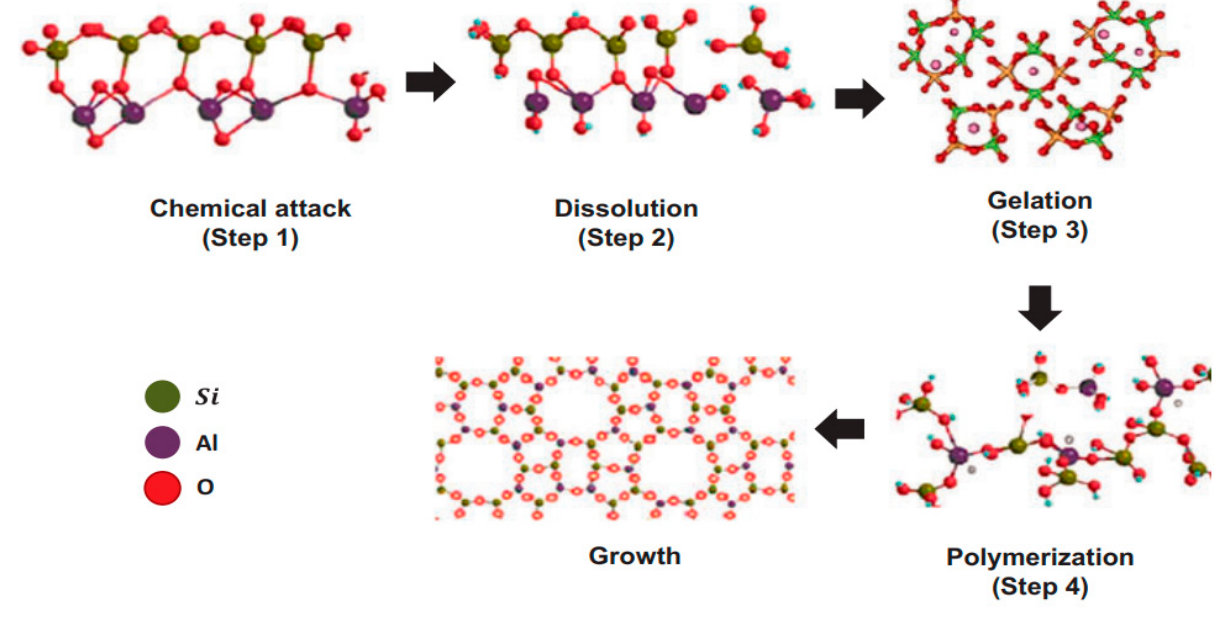
Figure 4. Mechanism of geopolymerization reaction [61].